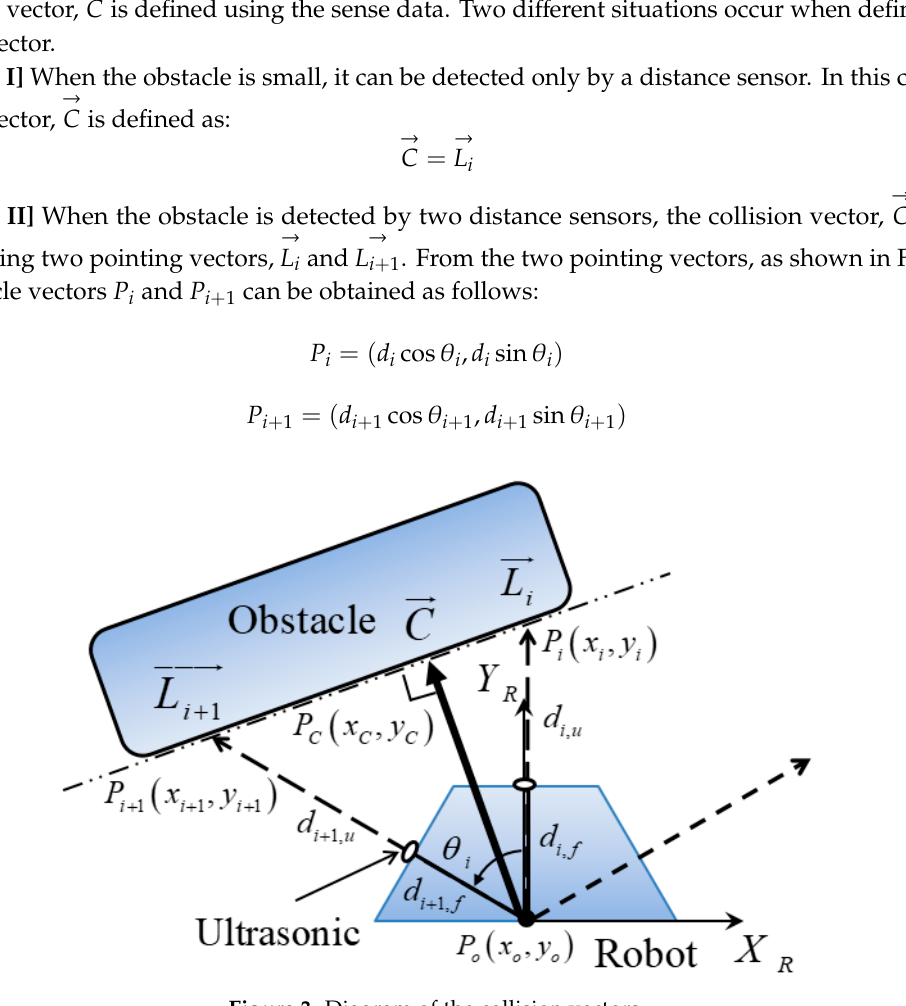
Figure 4. Rotation of the collision vector.